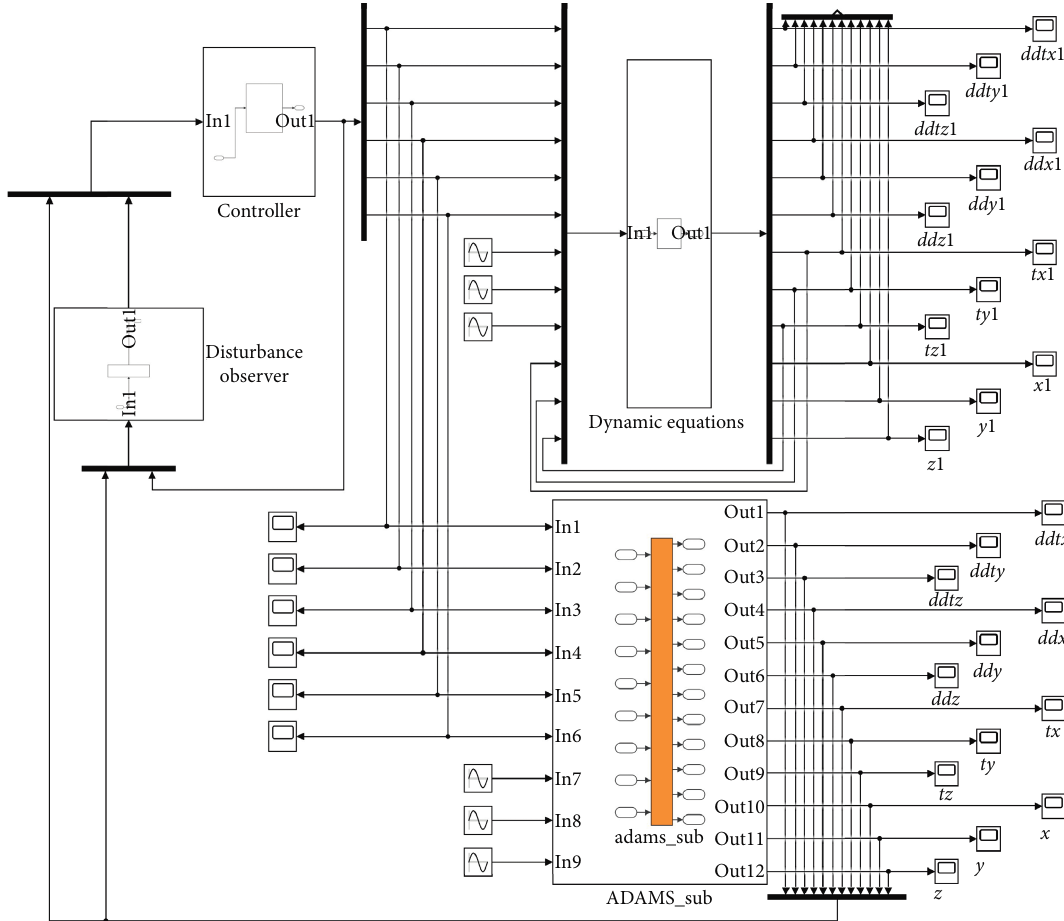
Figure 5: The cosimulation model of ADAMS and MATLAB.